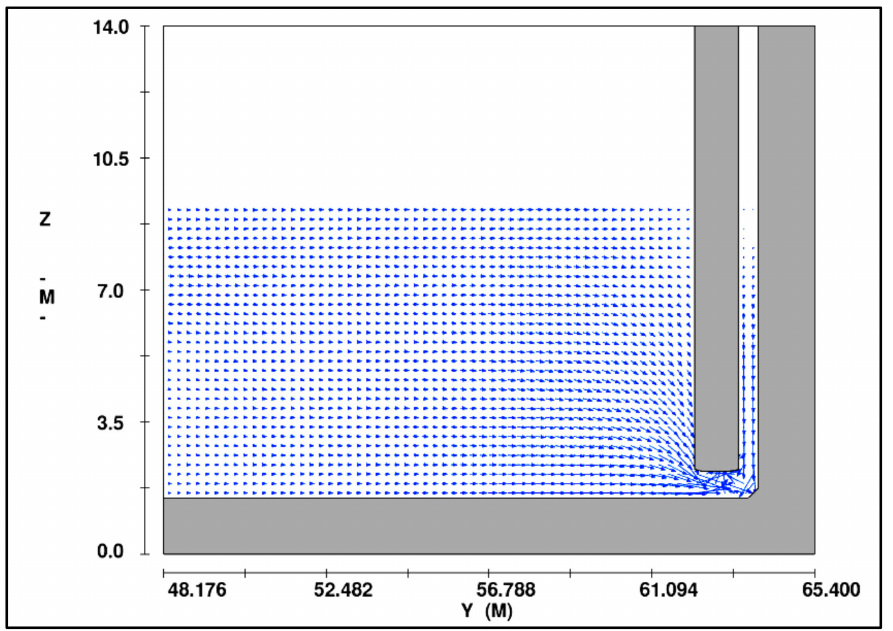
Figure 17. Vector field of velocity near a pump for suction in a vertical